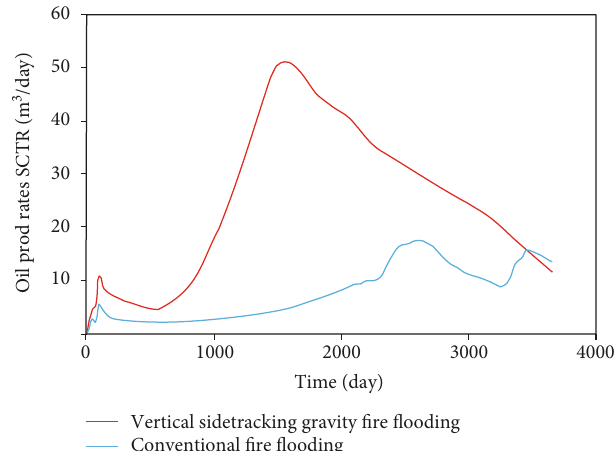
Figure 2: Comparison of oil production rate between conventional fi re fl ooding and vertical sidetracking gravity fi re fl ooding.